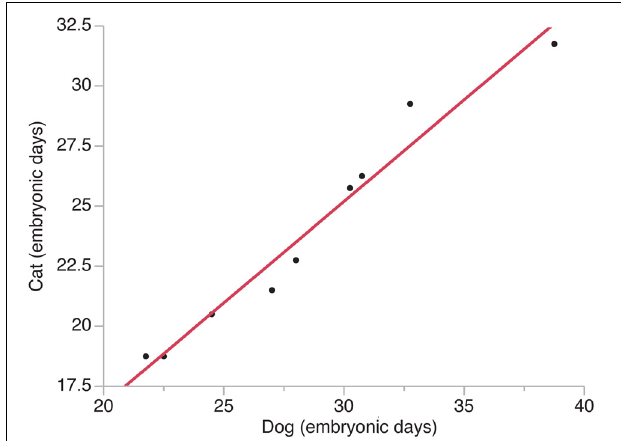
FIGURE 2 | The timing of neural events in cats is regressed against the timing of neural events in dogs. Time is expressed in embryonic days after conception with the day of conception designated as embryonic day 0. Neural events are listed in Table 1 .